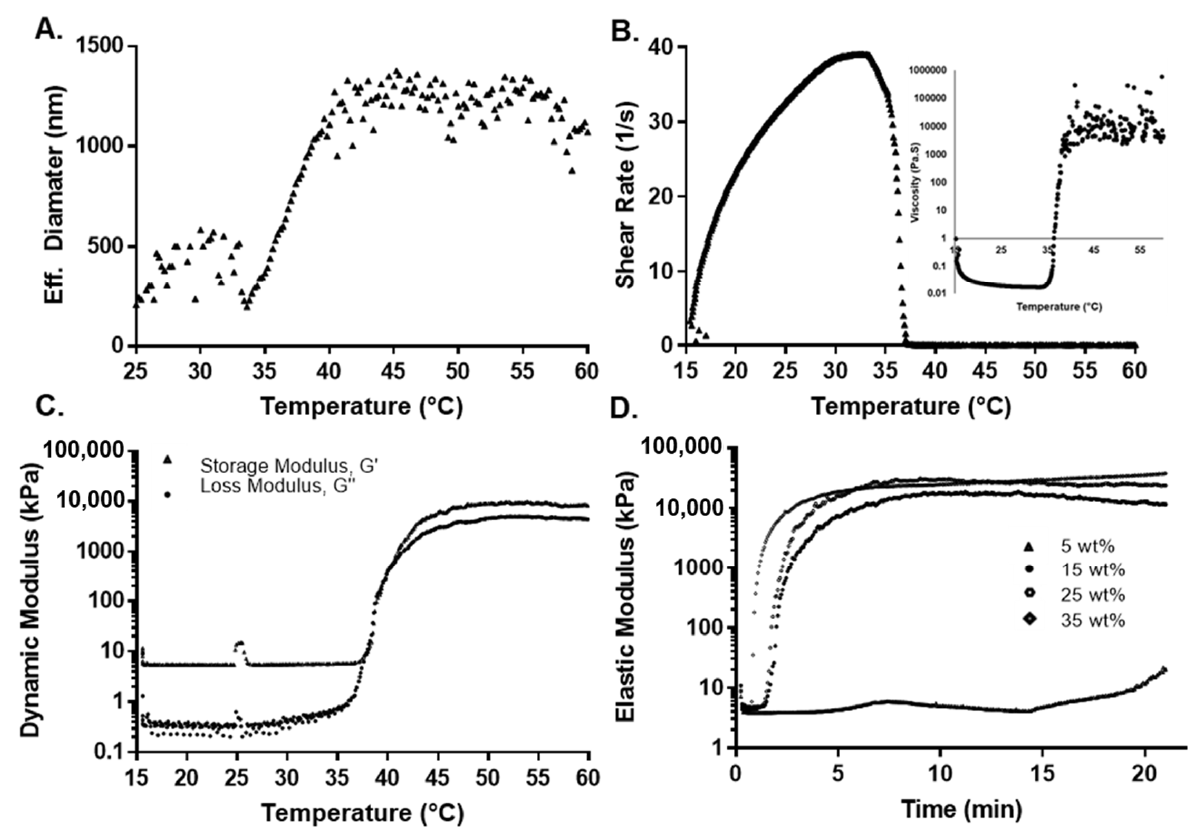
Figure 3. Thermal and mechanical characterization for 2:4:94 P400 terpolymer. ( A ) Effect of temperature on effective diameter measured by DLS. ( B ) Shear rate and viscosity as a function of temperature. ( C ) Rheological measurement of the dynamic modulus as a function of temperature. ( D ) Oscillatory rheological determination of the elastic modulus as a function of concentration at 37 °C.